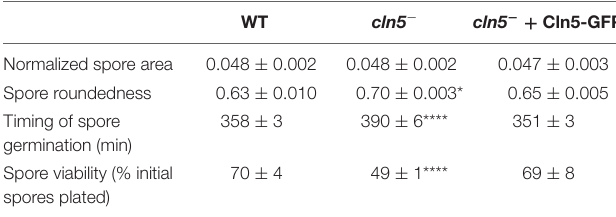
TABLE 1 | Effect of cln5 -deficiency on spore area, morphology, germination, and